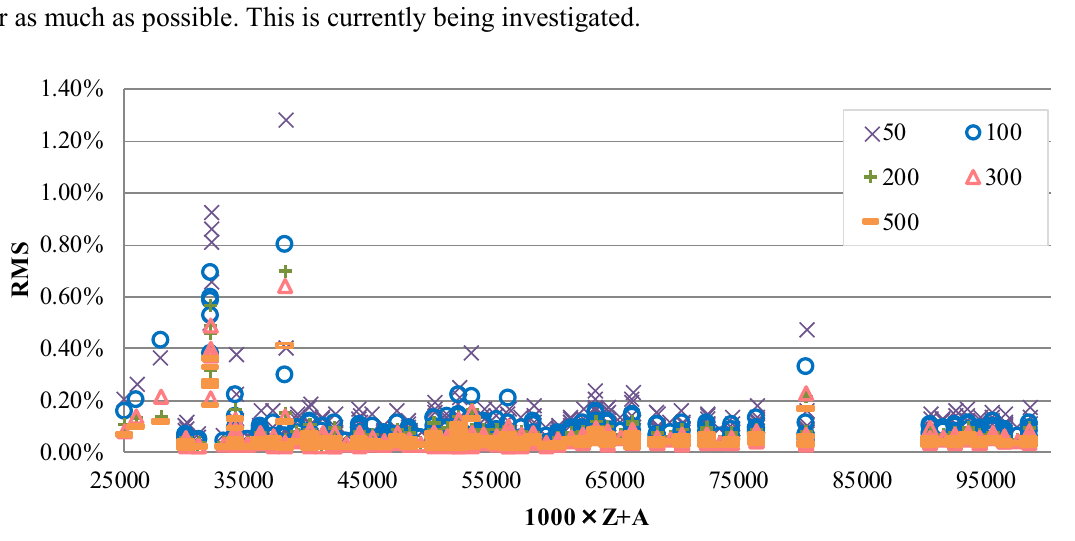
Figure 2. RMS values of probability table difference in each ladder number